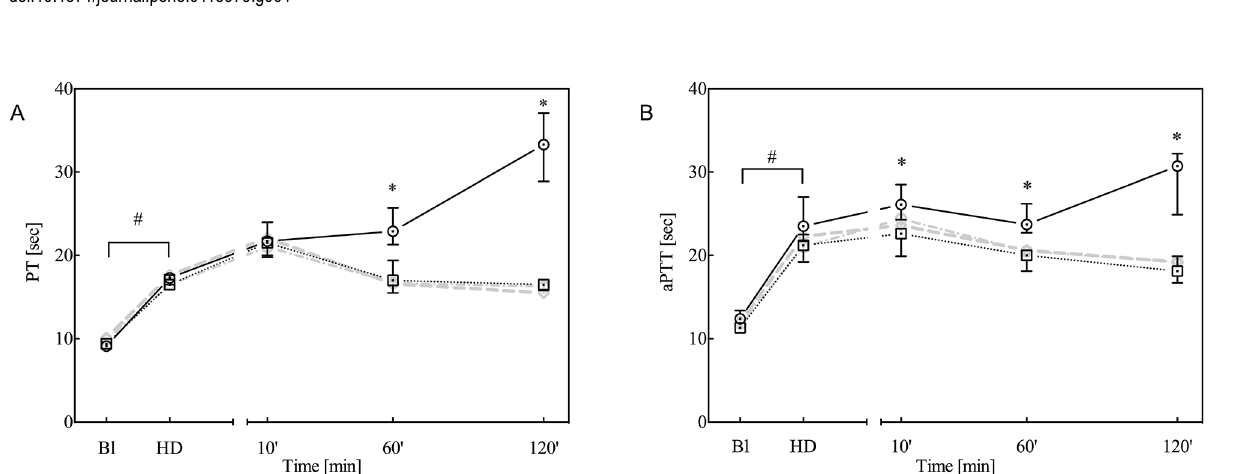
Fig 2. Prothrombin time (PT; A) and activated partial thromboplastin time (aPTT; B) at baseline (Bl), after haemodilution (HD) and at 10, 60 and 120 minutes after trauma. Data are presented as the median with inter-quartile ranges (IQR) for controls (solid black line, n = 7) and animals treated with 90 μ g/kg rFVIIa (dotted black line, n = 7). For comparison, data from animals treated with either 180 or 360 μ g/kg rFVIIa are presented as grey dotted lines. * P < 0.05 control versus rFVIIa; # P < 0.05 over time between baseline and haemodilution.